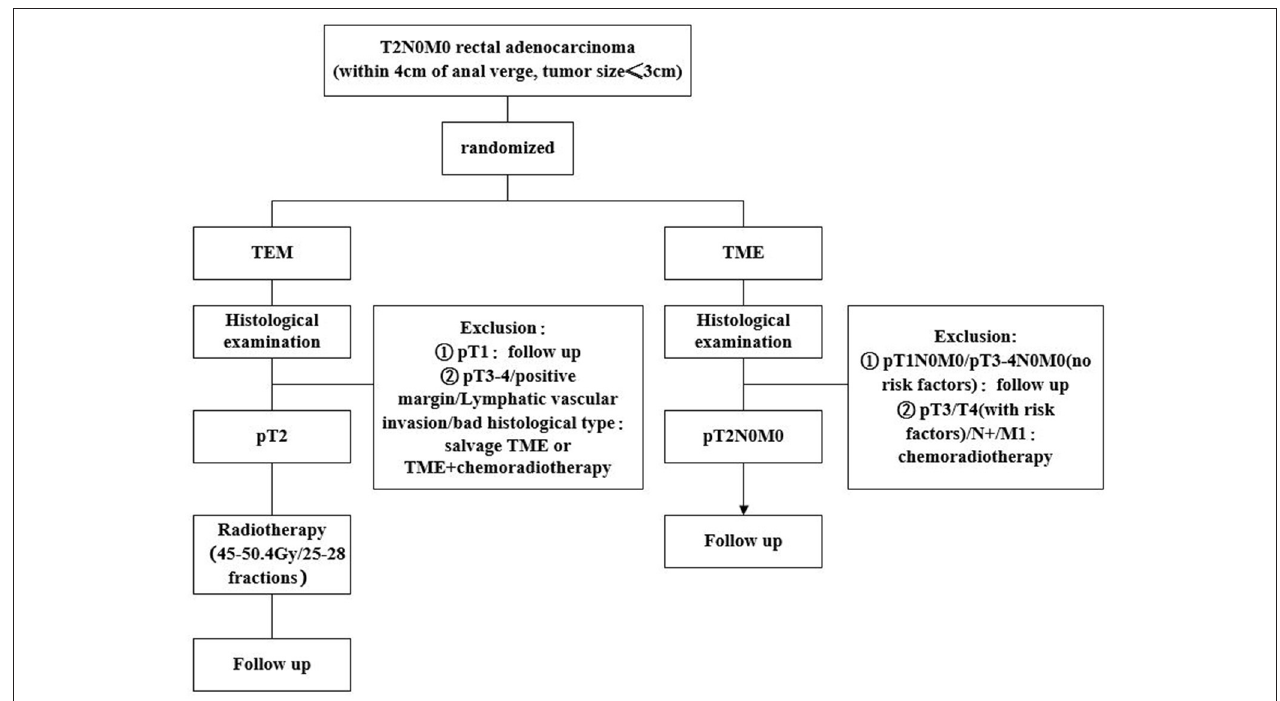
FIGURE 1 | Flowchart of the